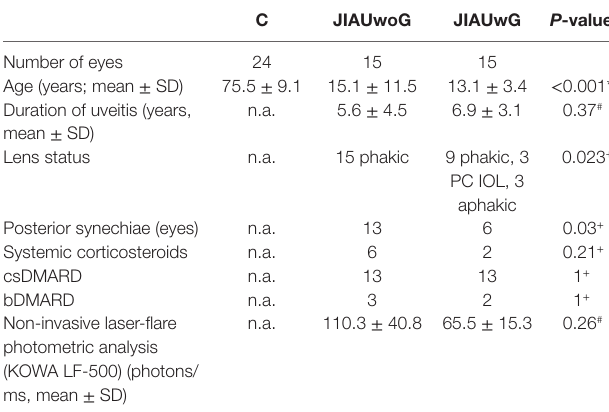
Table 1 | Demographic data of patients, treatment, and non-invasive laser-flare